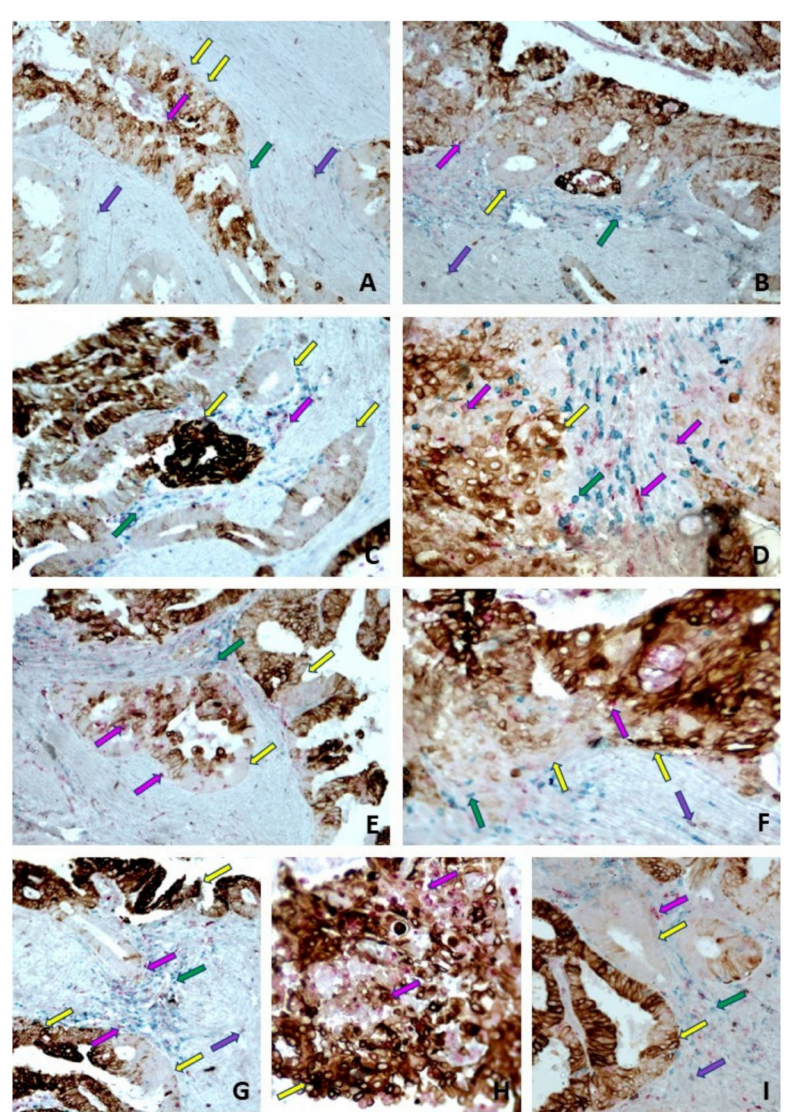
Figure 9. ( A – I )—Particular, multiple immunohistochemical labeling of hyperplastic transformed adenomyosis and adenomyosis. ( A – I ) areas of adenomyosis with complex hyperplasia and atypia show a weak glandular epithelium immunolabeled in brown with anti-CK7 antibody, areas of adenomyosis without atypia and normal endometrial epithelium, intensely immunolabeled with anti-CK7 antibody (gal darts). Periglandular inflammatory infiltrate is detected by antibodies: anti- tryptase, which shows mast cells in purple (purple arrows), anti-CD68 antibody, which marks periglandular and intraepithelial macrophages in red-pink (pink arrows), and anti-CD3 antibody, which high-lights lymphocytes T immunolabeled in green (green arrows). CK7: cytokeratin 7, CD34/68: cluster of differentiation 34/68, CD3: cluster of differentiation 3; [ × 100, ×